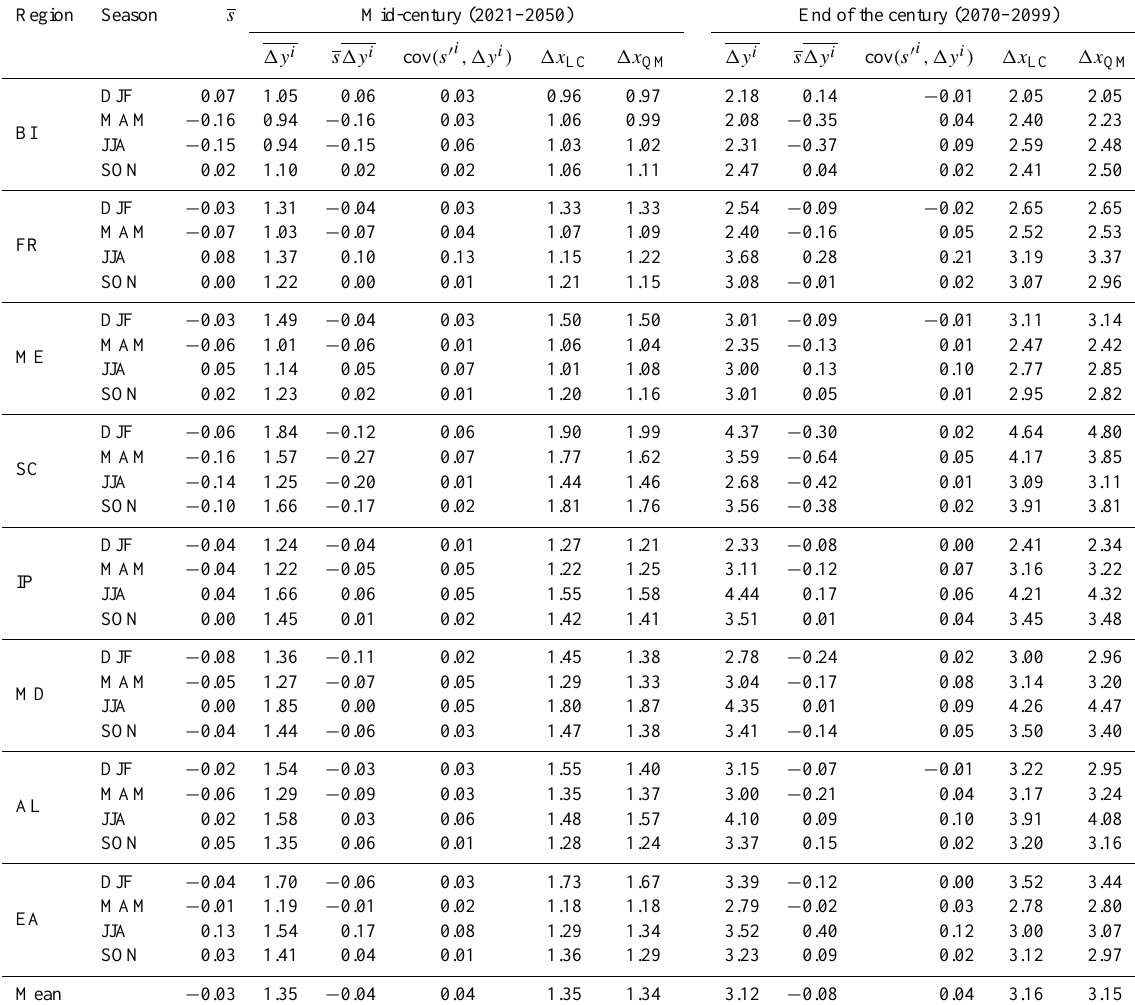
Table 1. Multi-model mean temperature error slopes ( s ), multi-model mean CCSs ( (cid:49)y i ), covariance error terms (cov (s (cid:48) i ,(cid:49)y i ) ), linearly corrected CCSs ( (cid:49)x LC ), and non-linearly corrected CCSs ( (cid:49)x QM ) for the periods 2021–2050 (left) and 2070–2099 (right) (K).